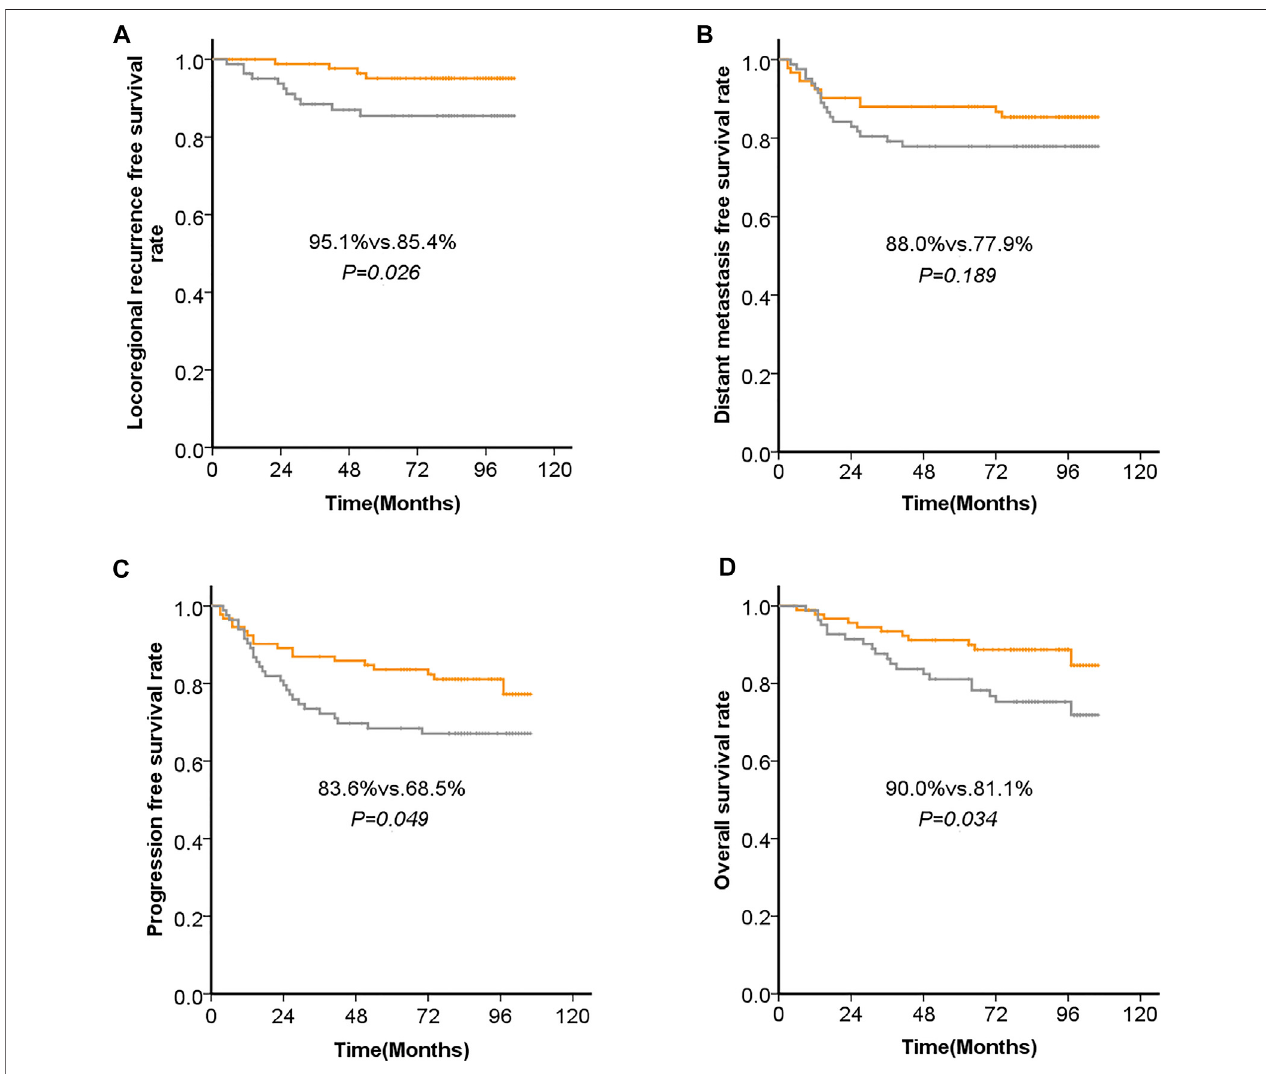
FIGURE 3 | Kaplan-Meier analysis of (A) the 5-years locoregional recurrence-free survival (LRFS), (B) 5-years distant metastasis-free survival (DMFS), (C) progression-free survival (PFS), and (D) overall survival (OS), with regard to the expression levels of ANG in patients with NPC before initial treatment.